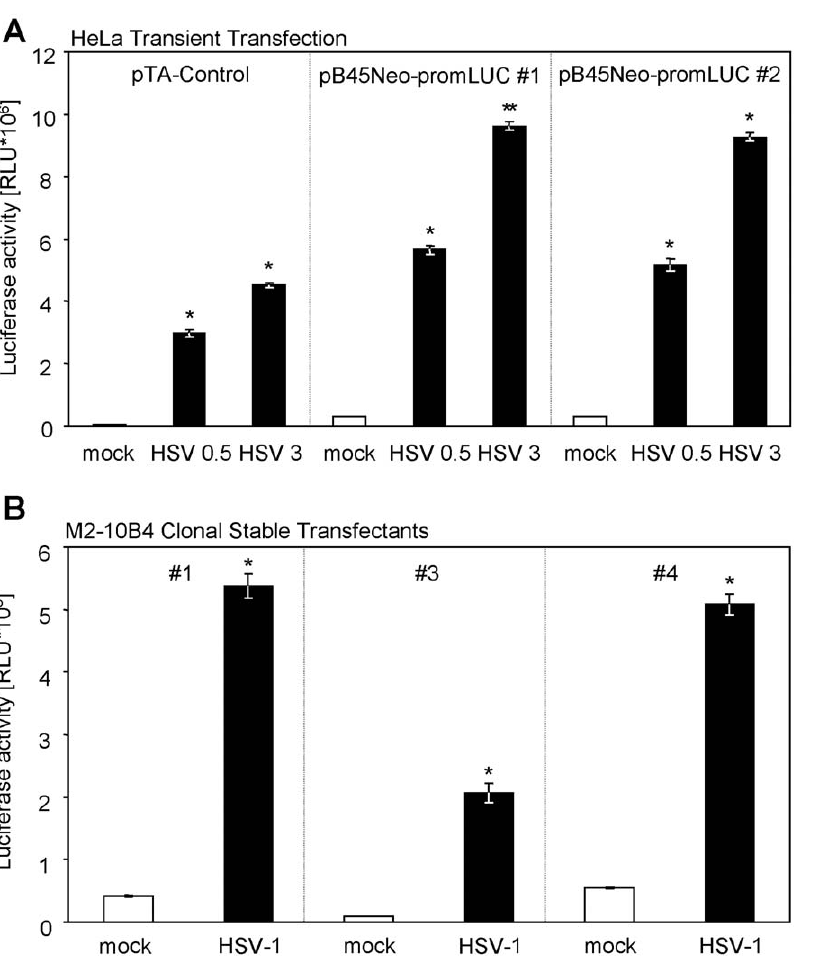
Figure 2. The episomal vector pB45Neo-promLuc confers herpesvirus responsiveness. ( A ) HeLa cells were transiently transfected with the pB45Neo-promLUC construct by nucleofection. Cells were infected with HSV-1 F strain (0.5 or 3 PFU/cell) or left uninfected. Cells were lysed and luciferase activity was determined. ( B ) G418-selected stable M2-10B4 cell clones ( # 1, # 3 and # 4) were infected with 5 PFU/cell HSV-1 F strain for 16 hours. Cells were lysed and luciferase activity was determined.